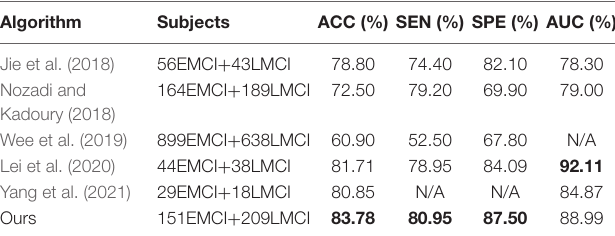
TABLE 6 | Result comparison of other EMCI vs. LMCI classification